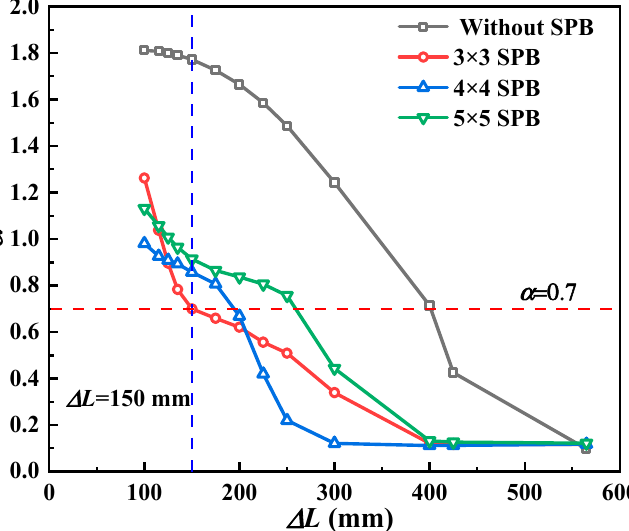
Figure 11. Maldistribution coefficient ( α ) varition of the entrance head with four kinds of SPB.